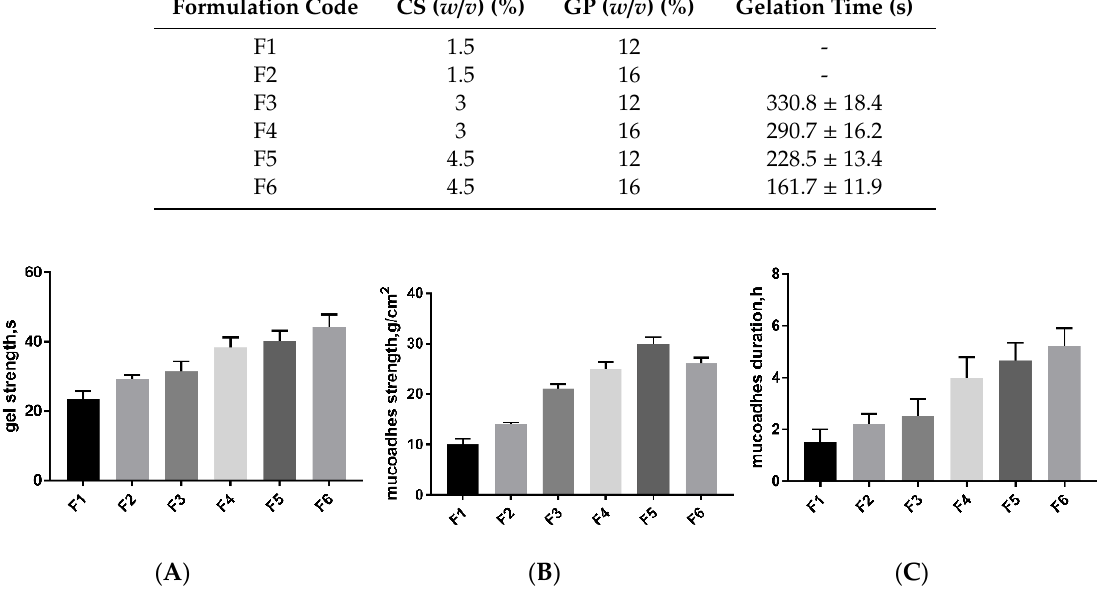
Table 2. Composition and gelation time at 34 ◦ C of formulations based on mixtures of chitosan with β -glycerophosphate ( β -GP). Table 3. Evaluation parameters for miR-146a in chitosan gel.